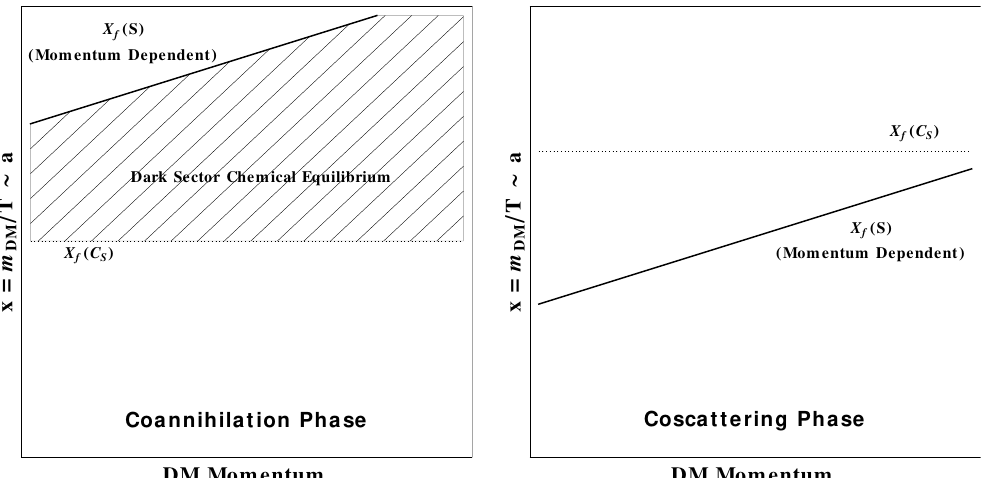
Figure 1 . Schematic plots of di(cid:11)erent scenarios, displayed by the freeze-out temperature and di(cid:11)erent momentum of ^ (cid:23) . Left: coannihilation phase where the DM relic density is dominantly de- termined by C S . Right: coscattering phase discussed in ref. [7] where DM relic density is determined by S